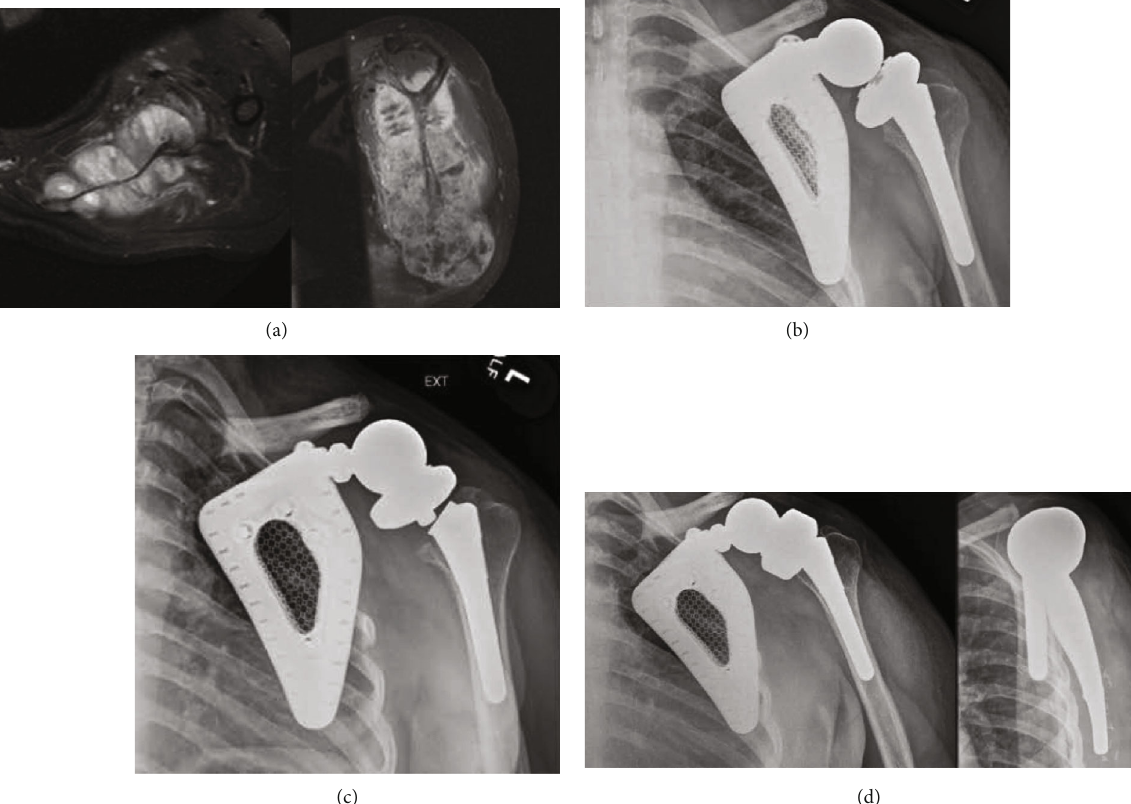
Figure 3: (a) MRI demonstrating expansive, in fi ltrative soft tissue malignancy about the scapula. (b) Immediate postoperative radiograph. (c) Radiograph demonstrating dissociation of the humeral tray and stem at the Morse taper six months postoperatively. (d) Immediate postoperative radiographs after revision of the humeral